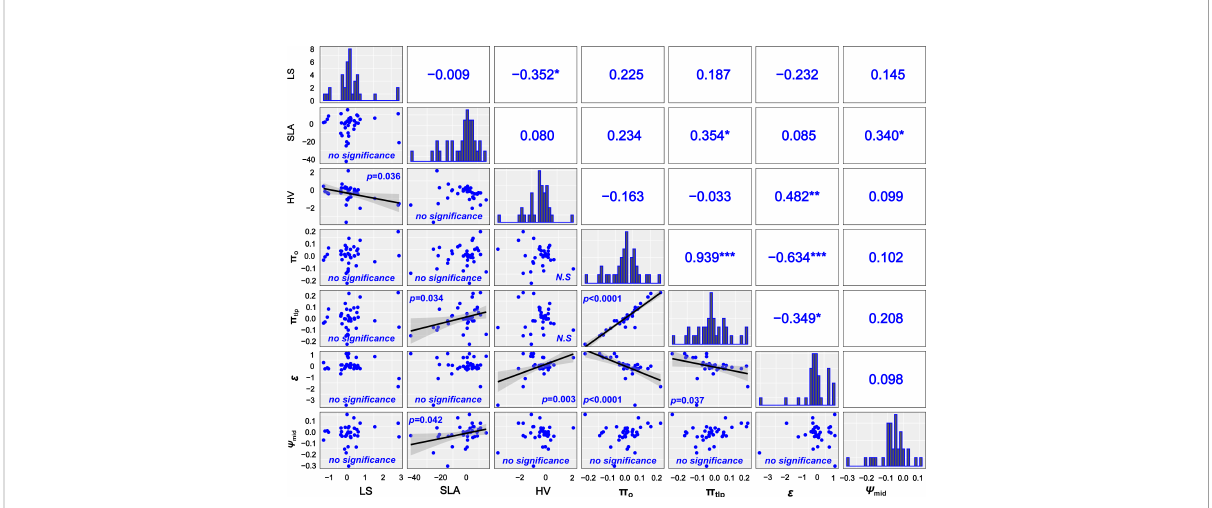
FIGURE 5 Correlation between leaf drought – tolerant traits after removing the phylogenetic signals. Solid lines represent the linear regressions, and shallow gray bands represent 95% con fi dence in the lower triangular intervals. The correlation coef fi cients are given respectively in the graphics above the diagonal. Histograms showing trait value distributions are given in the diagonal. * P < 0.05, ** P < 0.01, *** P < 0.001. N.S., non-signi fi cant relationship.